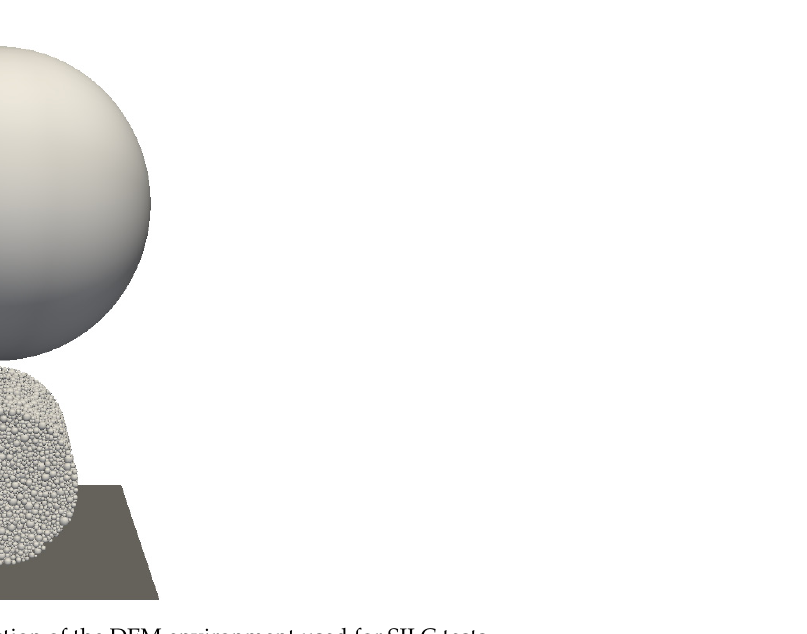
Figure 2. A depiction of the DEM environment used for SILC tests.